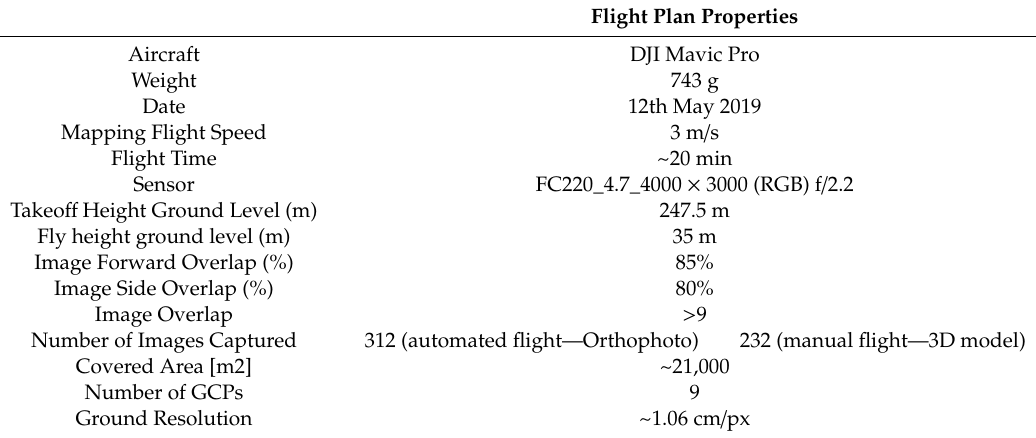
Table 1. UAV and ground survey details.